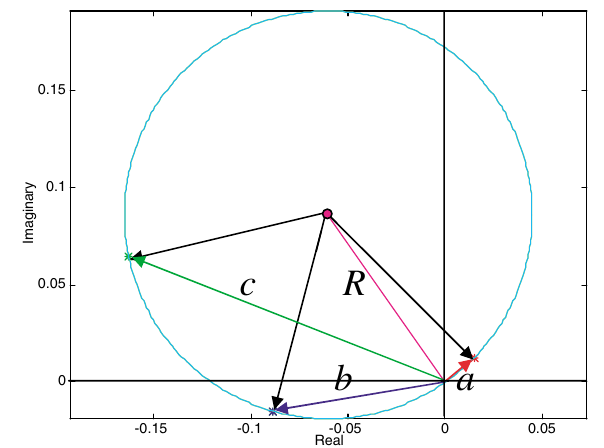
FIG. 9. (Color) Phasor plot of matching solution check. a , b , values from matched symmetrized structures and c are S 11 with three, two, and one symmetrized cells, respectively, and R is the deduced residual coupler mismatch.